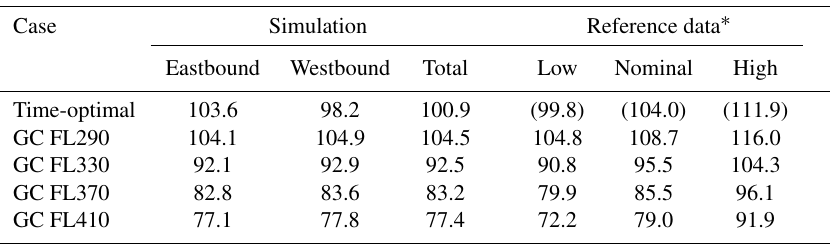
Table 10. The mean fuel consumption (in kg ( fuel ) min − 1 ) for the time-optimal and great circle cases. Eastbound: average of 52 eastbound flights; Westbound: average of 51 westbound flights; and Total: average of 103 flights. Columns 5 to 7 show the reference cruise fuel consumption (in kg ( fuel ) min − 1 ) for three different weights (low, nominal and high) in the international standard atmosphere. BADA provides the reference data at specific flight altitudes. Therefore, the reference values for the time-optimal case in parentheses were estimated from the reference data at FL290 and FL330 by linear interpolation (the mean flight altitude of the time-optimal case was h = 9271m, which is the value between FL290 ( = 8839m) and FL330 ( = 10058m)).